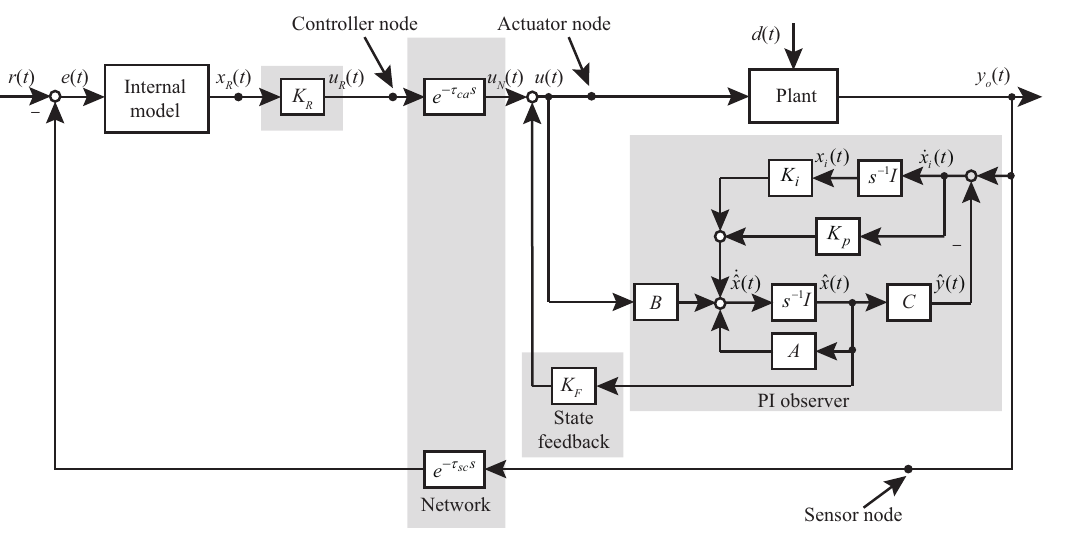
Figure 5. Configuration of PIO-based